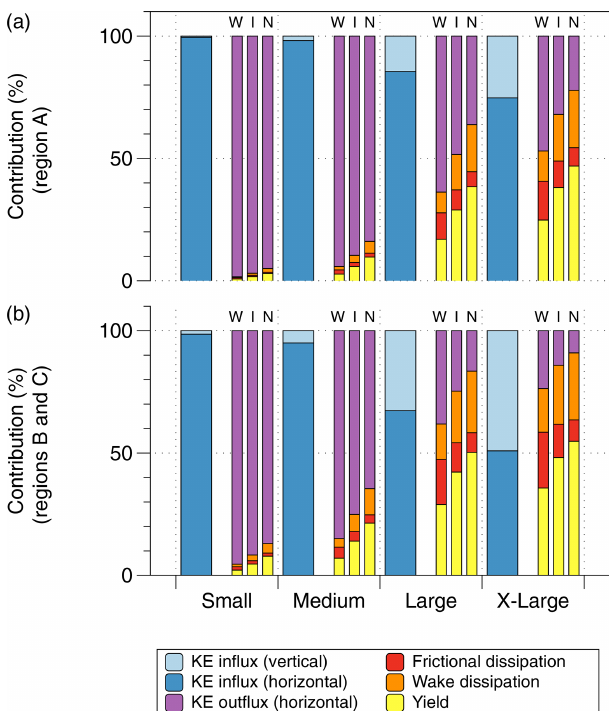
Figure 5. Diagnosed terms of the kinetic energy budget, with the relative contributions to the influxes of kinetic energy (KE) shown in the left column and the conversion to electricity, dissipation, and outflux of kinetic energy shown in the three right columns (for three different turbine spacings: W: wide; I: intermediate; N: narrow). The horizontal and vertical contributions to the KE influx are shown by dark and light blue, respectively. The yield (conversion to elec- tricity) is shown in yellow and the dissipation by surface friction (red) and wake turbulence (orange) and outflux of kinetic energy (purple). The plots show the KE budgets for the scenarios of wind farms of four different areas (S, M, L, and XL) for region A (cen- tral US, land, a ) and for regions B and C (North Sea and Straight of Magellan, ocean, b ). The colours of the bars match the arrows shown in Fig. 1.